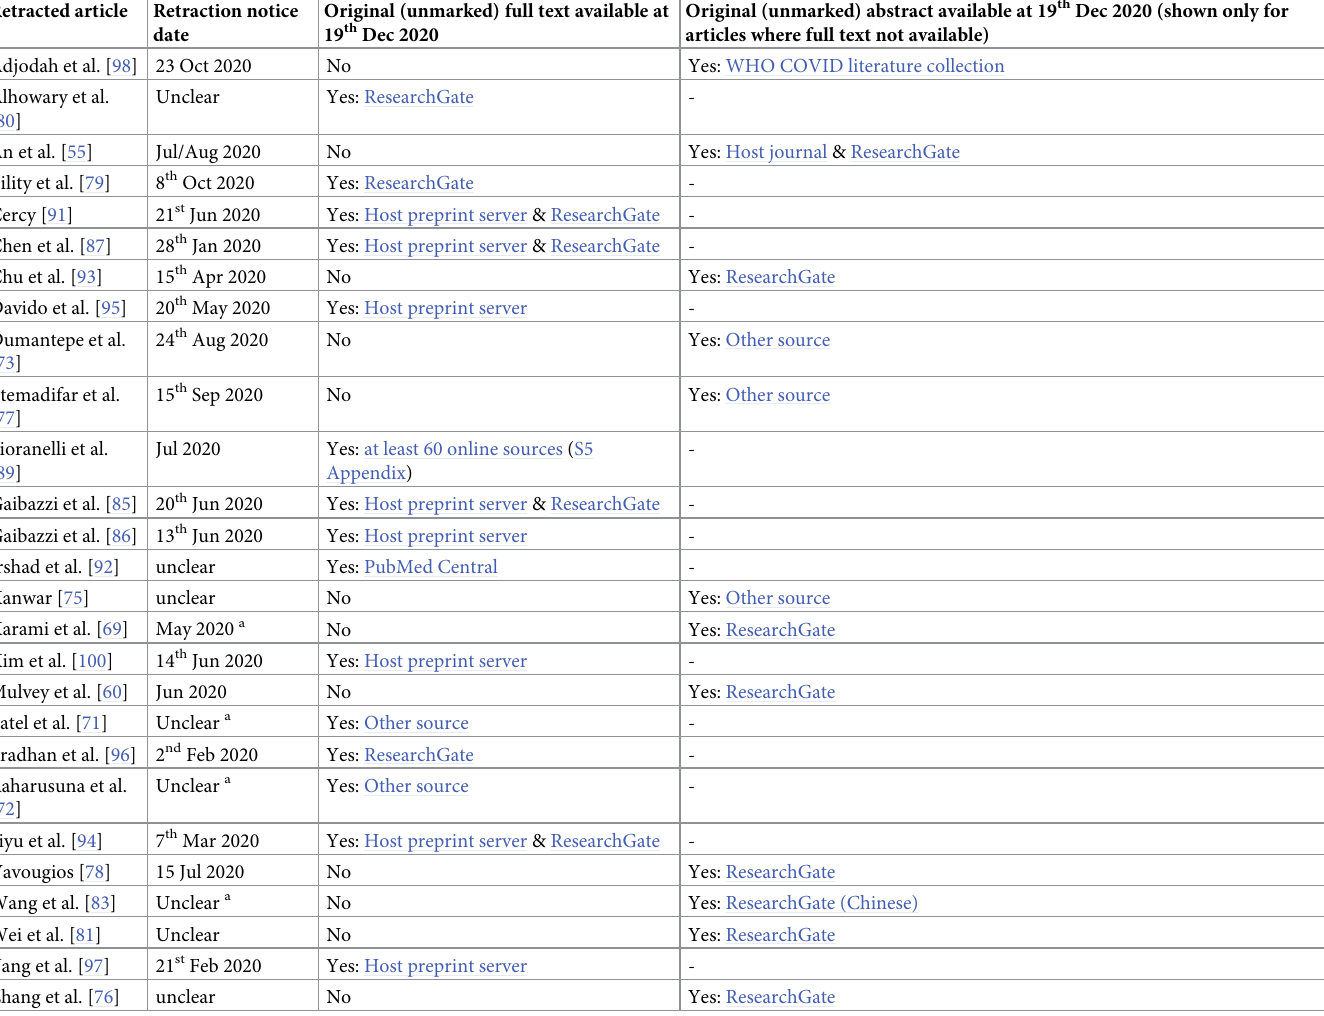
Table 2. Availability of retracted COVID-19 articles as unmarked original full-text papers and/or abstracts after